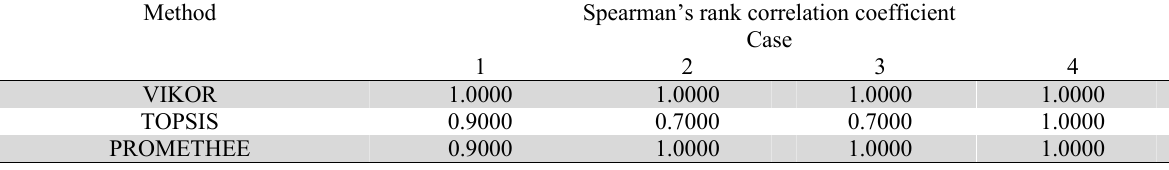
Spearman’s rank correlation coefficients for Example